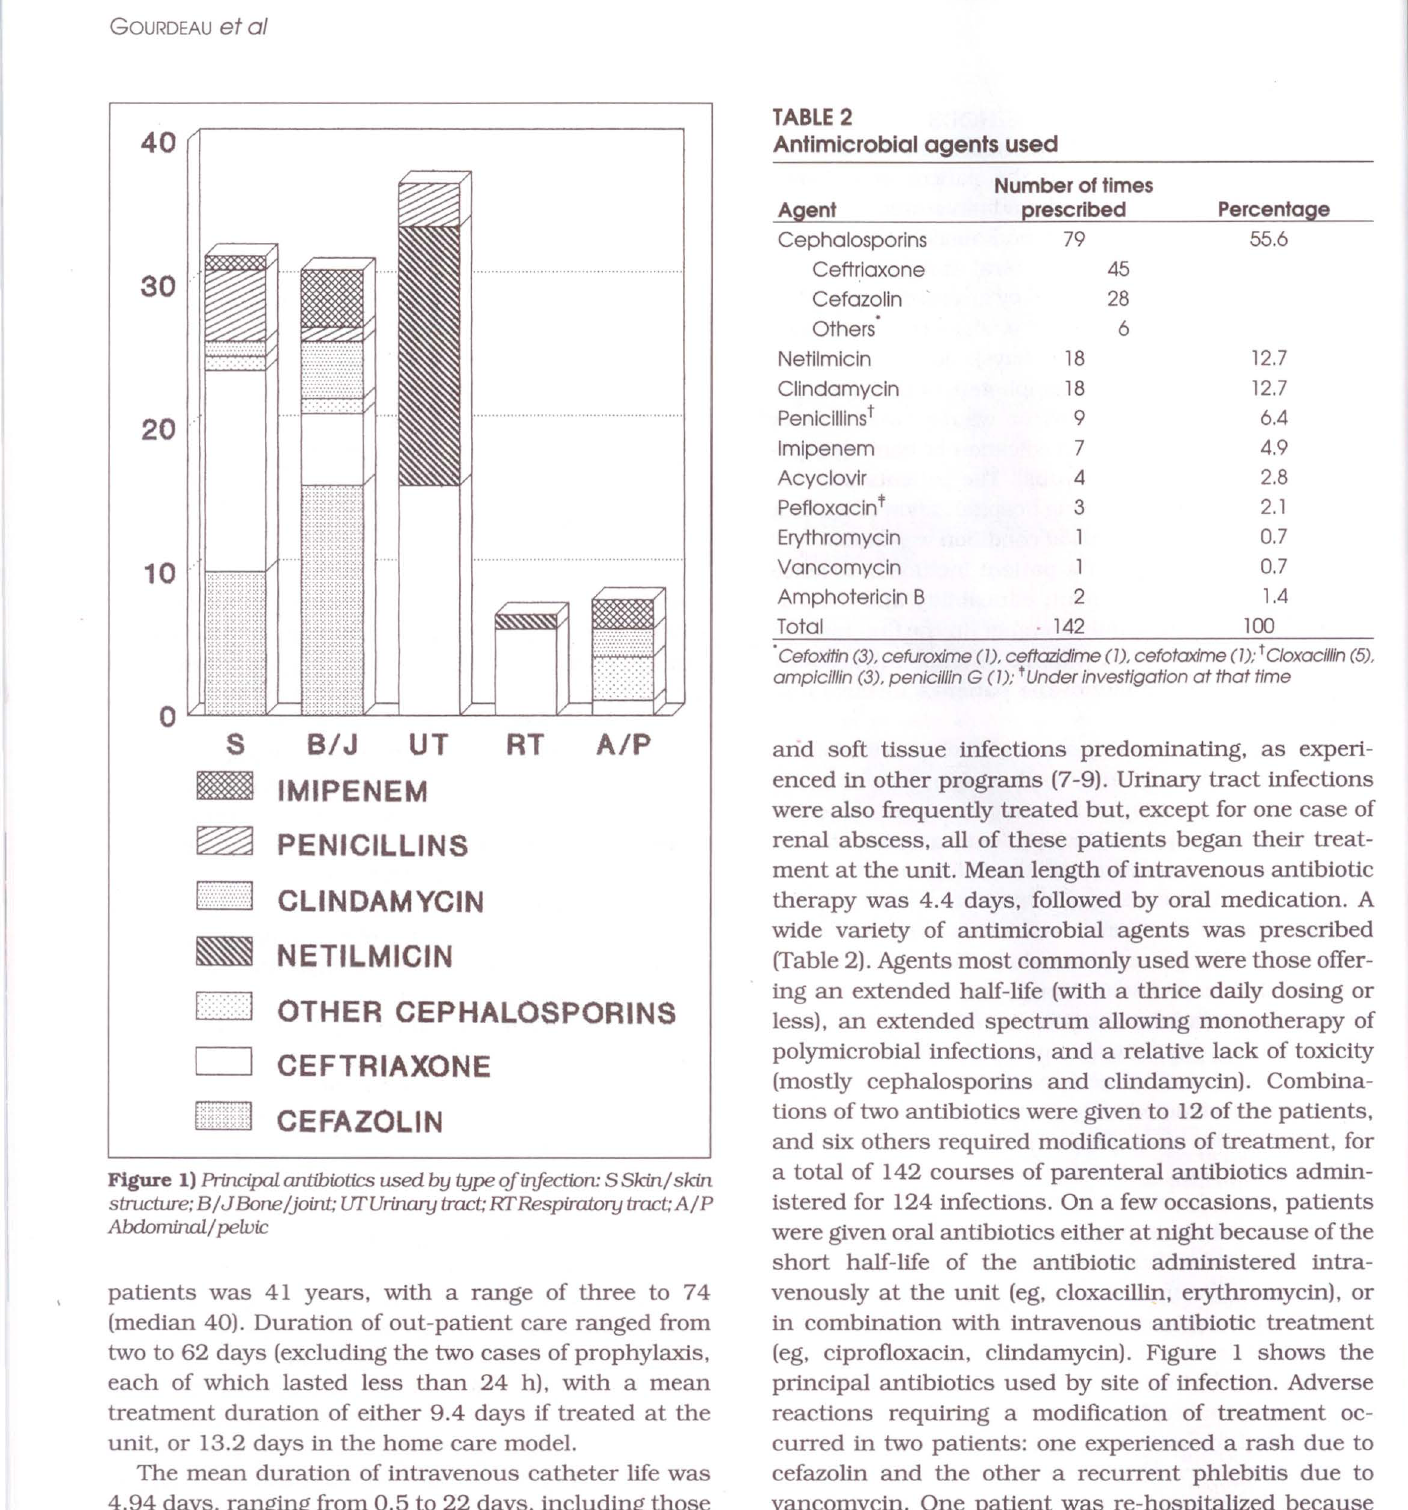
Figure 1) Principal antibiotics used by type of irifection: S Skin/ skin structure; B I J Bone/joint; UTUrinary tract; RT Respiratory tract; A/ P Abdominal/ pelvic